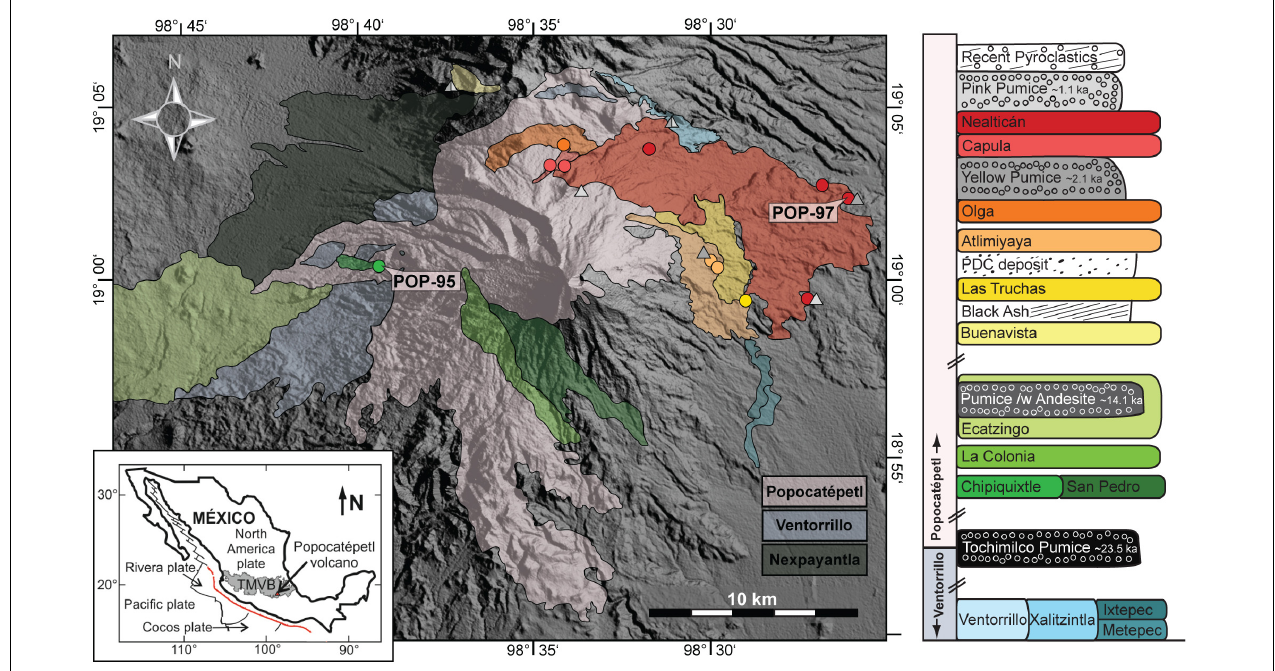
FIGURE 1 | Simplified geological map and stratigraphy of the Popocatépetl Volcanic Complex (PVC). Only effusive units are shown for clarity. Previous edifices are outlined in muted colors, lavas of the last ∼ 23.5 ka are colored blue to red according to their relative ages. Sample locations are indicated as circles (lavas) and triangles (pumices). Sample numbers are given for the samples used for MELTS models. Modified from Mangler et al.